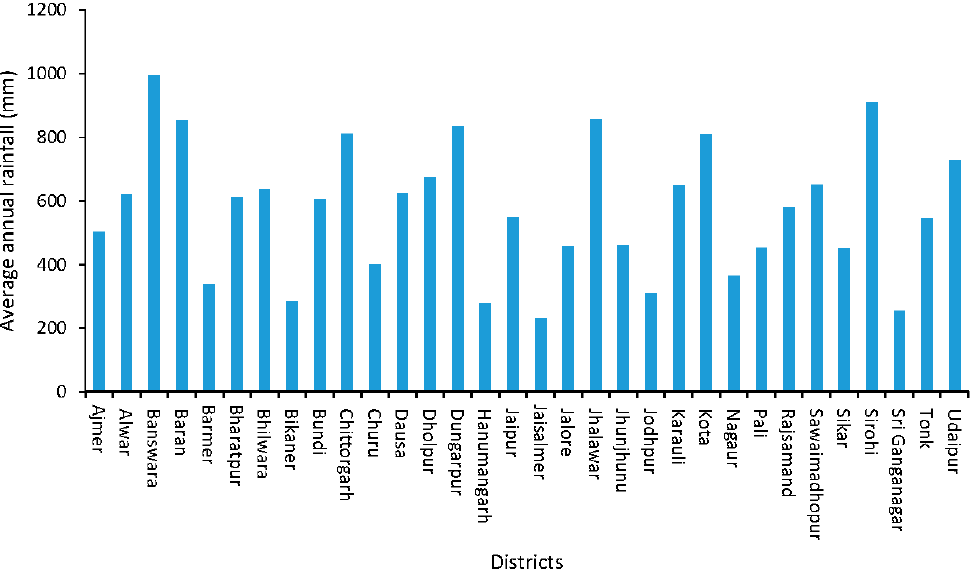
Figure 3. District average annual rainfall hyetograph in Rajasthan from 2004 to